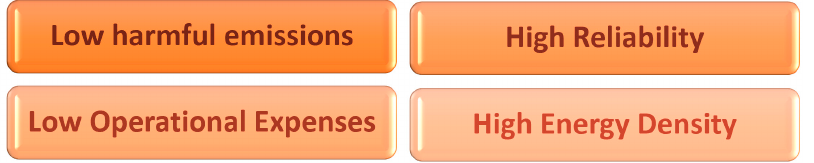
Figure 2. Pros of nuclear technologies as given in the NS Energy publication.